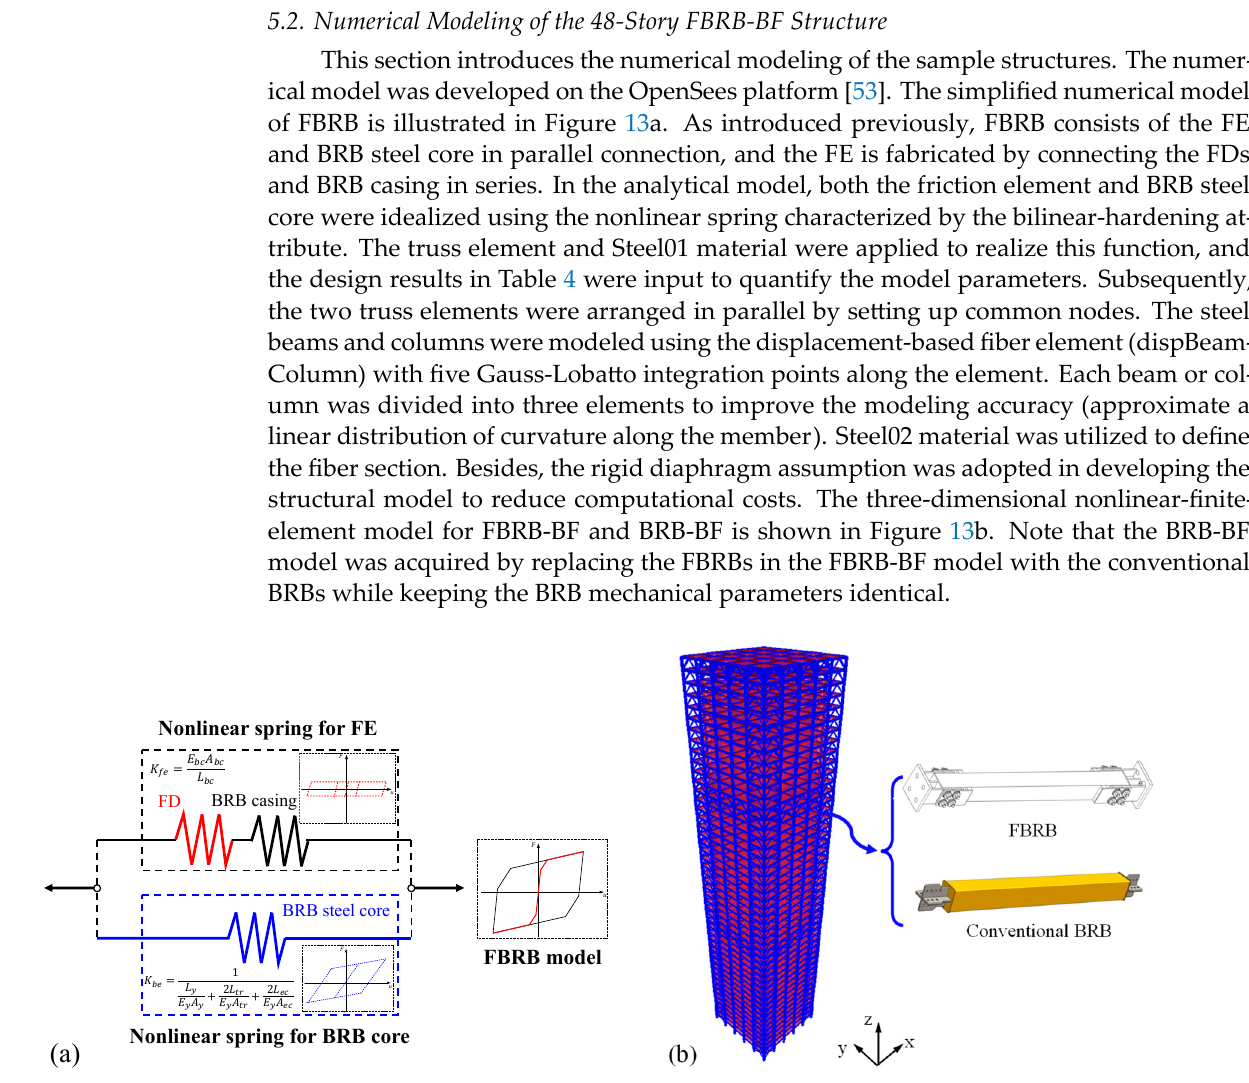
Figure 13. Analytical models for FBRB‑BF and BRB‑BF: ( a ) simplified analytical model for FBRB; and ( b ) three‑dimensional finite‑element models for FBRB‑BF and BRB ‐ BF.